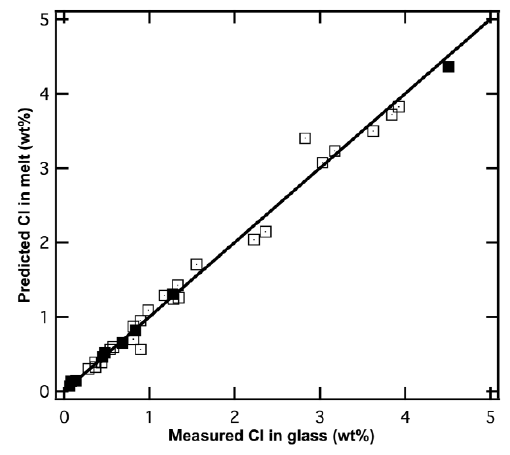
Fig. 7. Correlation between measured Cl solubili- ties and those predicted by the model of Webster and De Vivo (2002). All melts are saturated with a Cl- rich brine at 200 MPa pressure and temperatures of 786-1193°C. Filled symbols show experiments used to generate the model association coefficients and open symbols show melt compositions for which the Cl solubility was calculated using the model associ- ation coefficients. Typical 1- σ analytical precision for measured Cl contents are on the order of 0.05 to 0.1